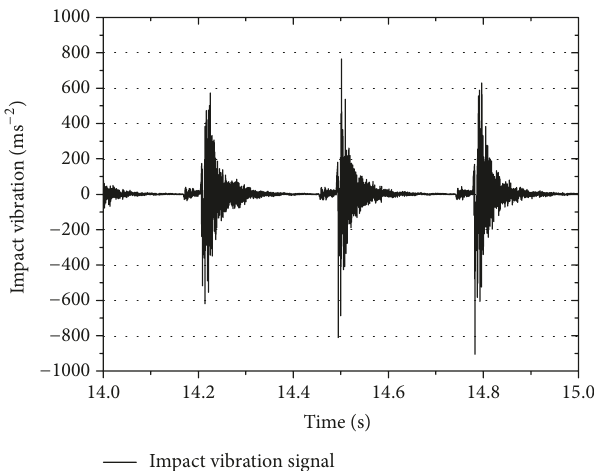
Figure 7: Measured vibration signal from the operating hydraulic breaker.